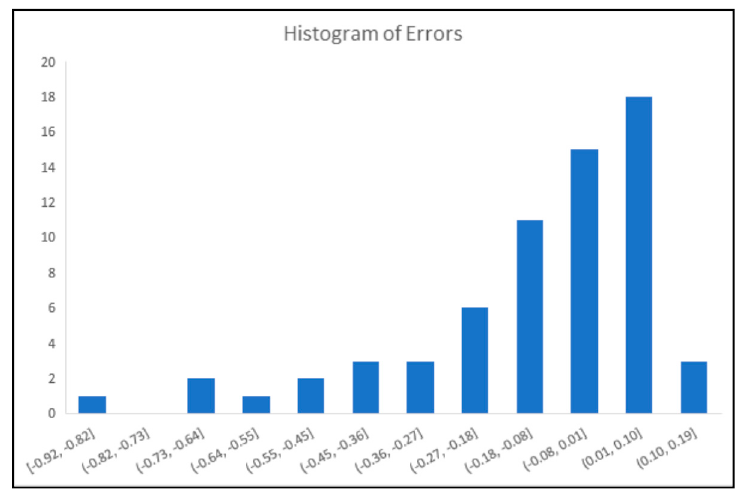
Figure 7. Histogram showing the distribution of the 65 error pairs.